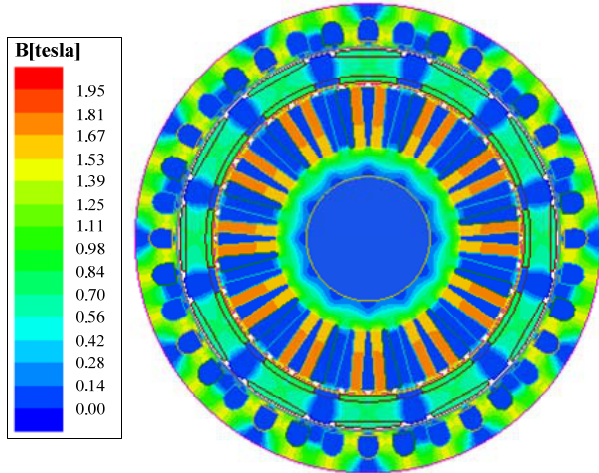
Figure 5. Flux density distribution under rated load